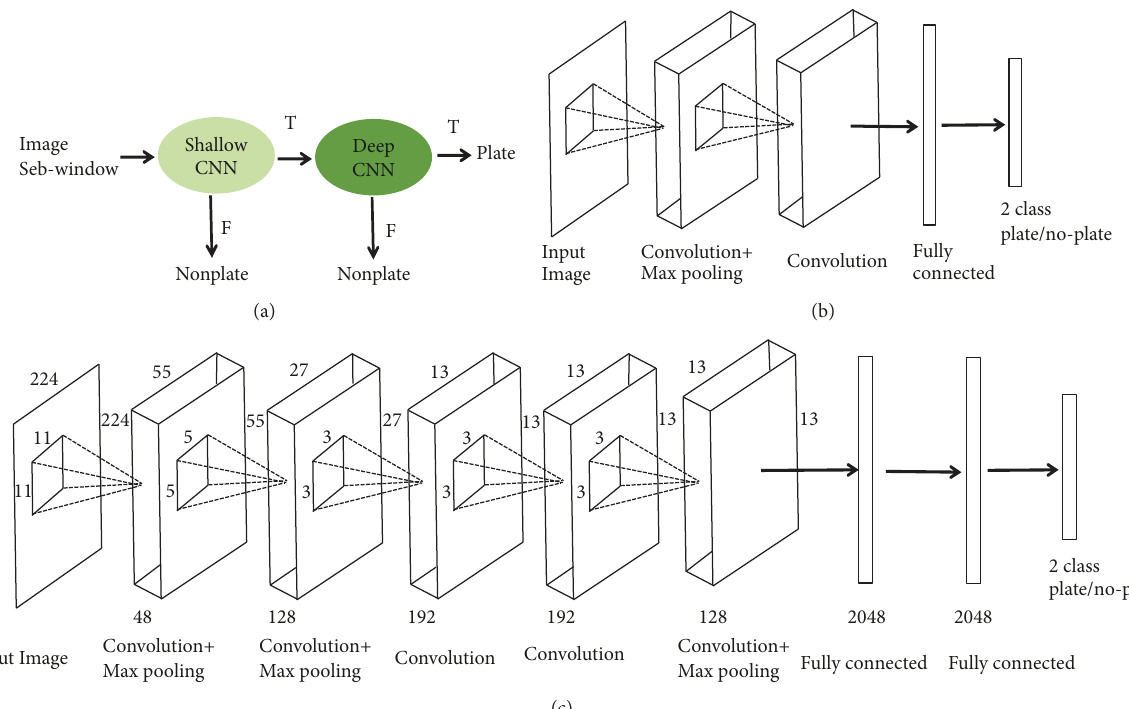
Figure 1: The framework of the proposed license plate detector. (a) The overall framework of our license plate detector. (b) The structure of the shallow CNN. (c) The structure of the deep